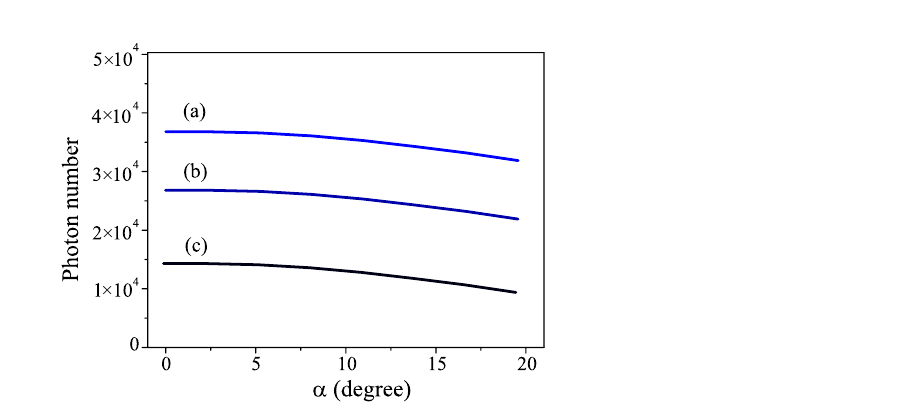
Figure 14. Number of photons of the collimated X-ray radiation for bandwidth at 10% as a function of the complementary angle α between the electron beam and THz radiation (head-to-head interaction α = 0.) λ w =4.5 cm, λ THz = 15 µ m. λ X = 0.5 nm, ( a ): L c = 2%, ( b ): L c = 4%, ( c ): L c =